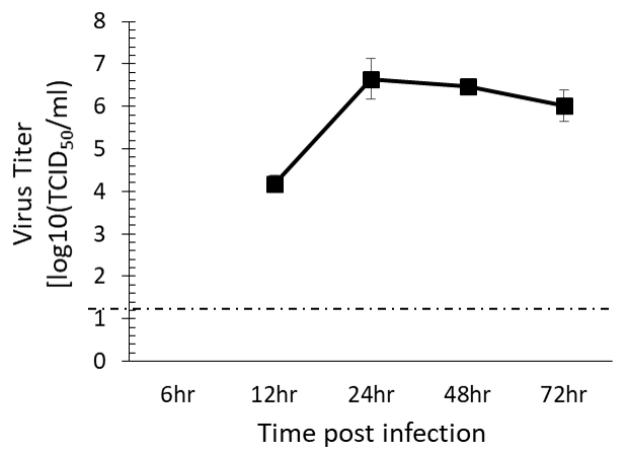
Figure 1. CHIKV 181/25 replication in hPDF cells. HPDF cells were infected with CHIKV 181/25 and virus titers were measured in the cell supernatants at 24 h post infection. Values presented as ± SEM. The dashed line indicates the limit of detection of assay.